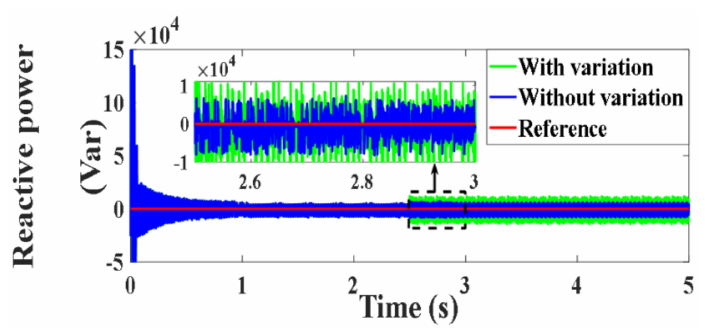
Figure 170. Reactive power under PVC (var).